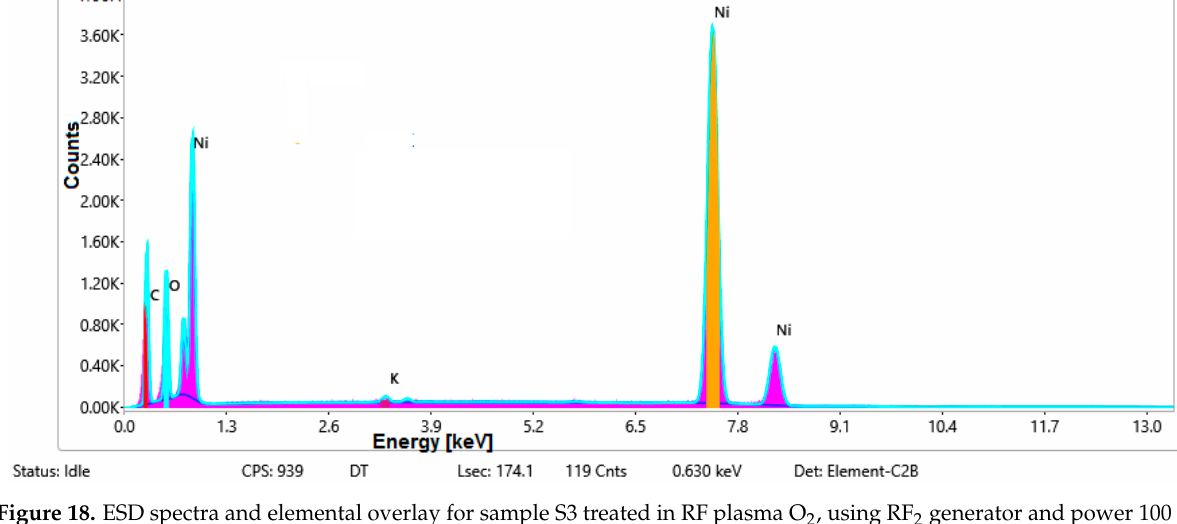
Figure 19. Smart elemental mapping overlay for sample S3 treated in RF plasma O 2 , using RF 2 gen- erator and power 100 W and Ni paste. 4. Discussion The experiments in RF plasma O 2 were prepared using a variation in power (200 W, 100 W and 50 W), in frequency (using two different RF generators having the frequencies 13.56 MHz (RF 1 ) and 40 kHz (RF 1 )).